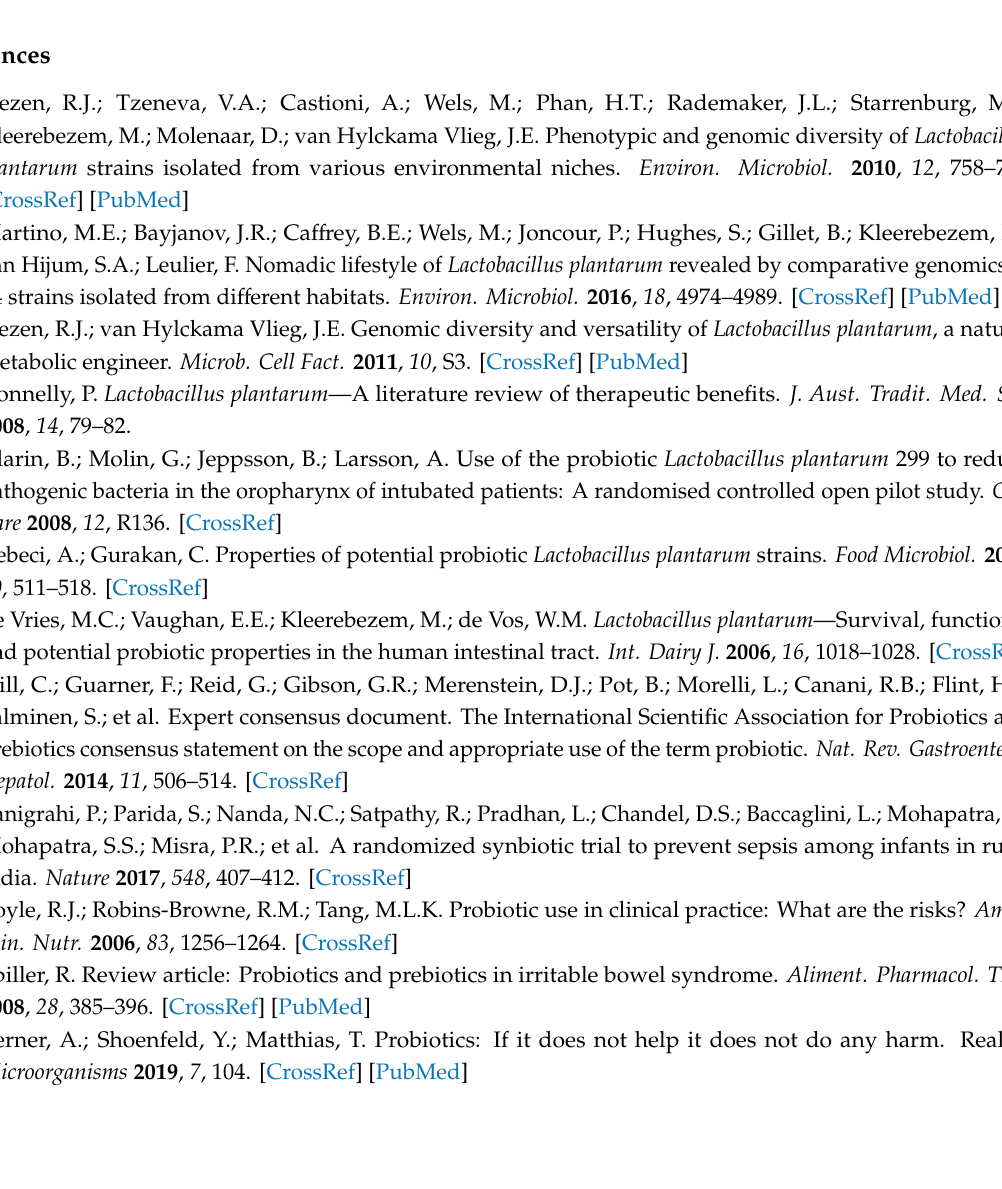
Table S1: Sequence coverage, Figure S1: Lactobacillus plantarum plasmids pMF1298-1 to